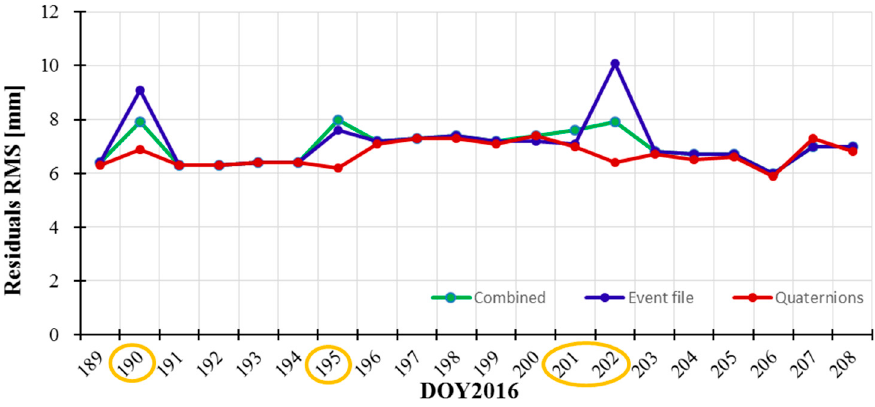
Figure 7. Residuals RMS based on different attitude modes.